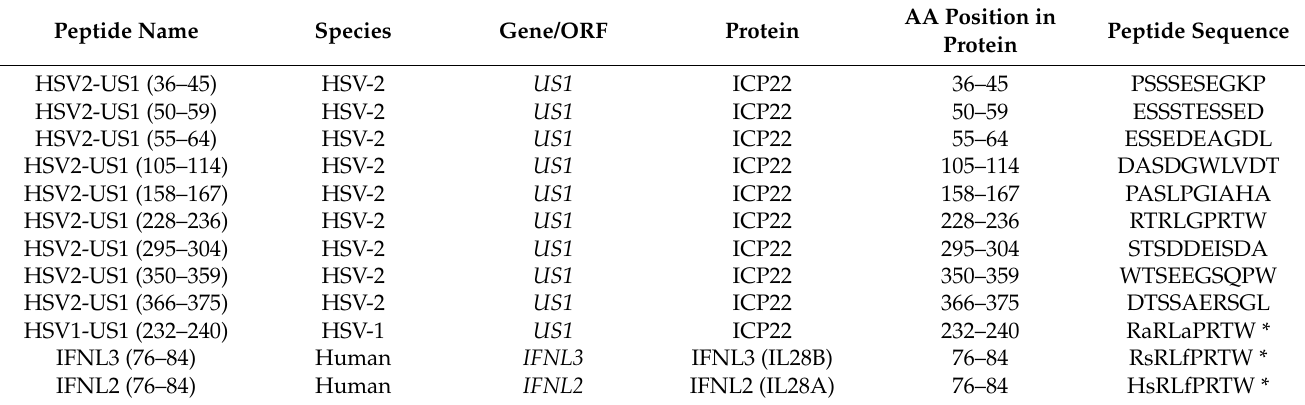
Table 1. Peptides tested for reactivity with polyclonal HSV-2-reactive CD8 T-cell